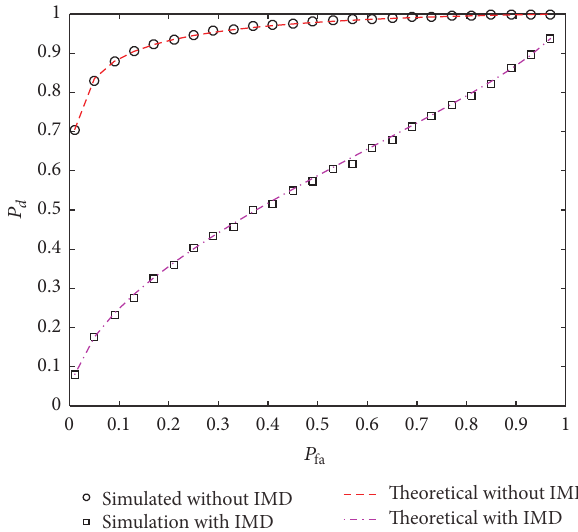
Figure 3: 𝑃 fa versus 𝑃 𝑑 with SNR at − 15 dB, IMD of 10dB, and 𝑁 = 1000 .